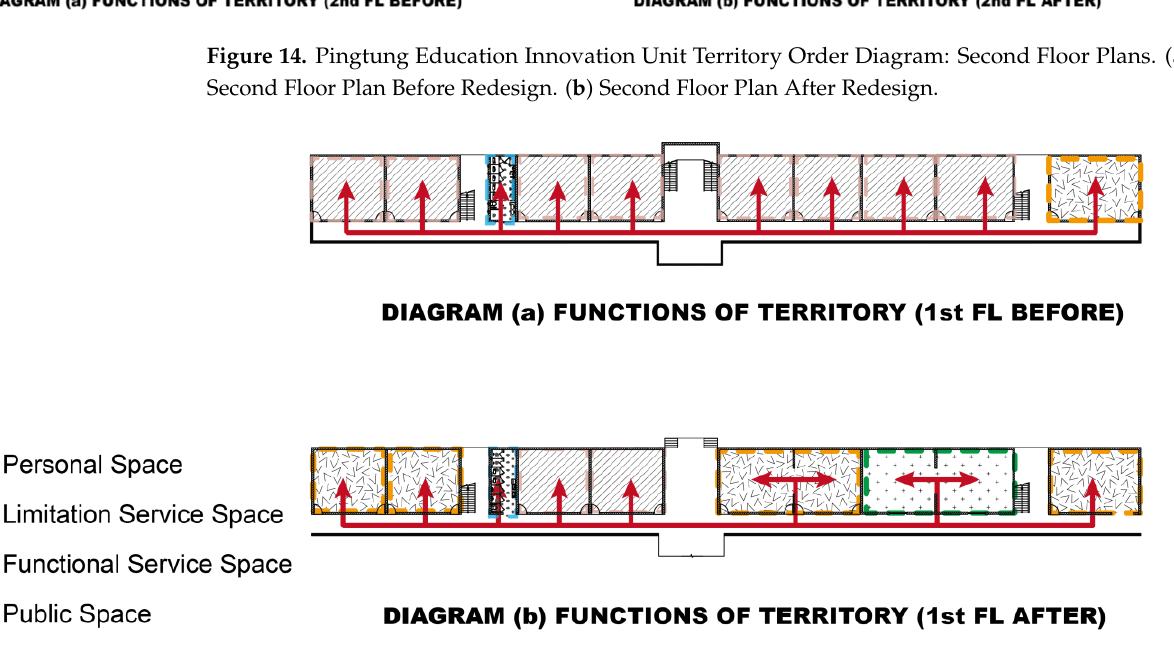
Figure 15. Pingtung AI Agri Hub Territory Order Diagram: First Floor Plans. ( a ) First Floor Plans Before Redesign. ( b ) First Floor Plans After Redesign.